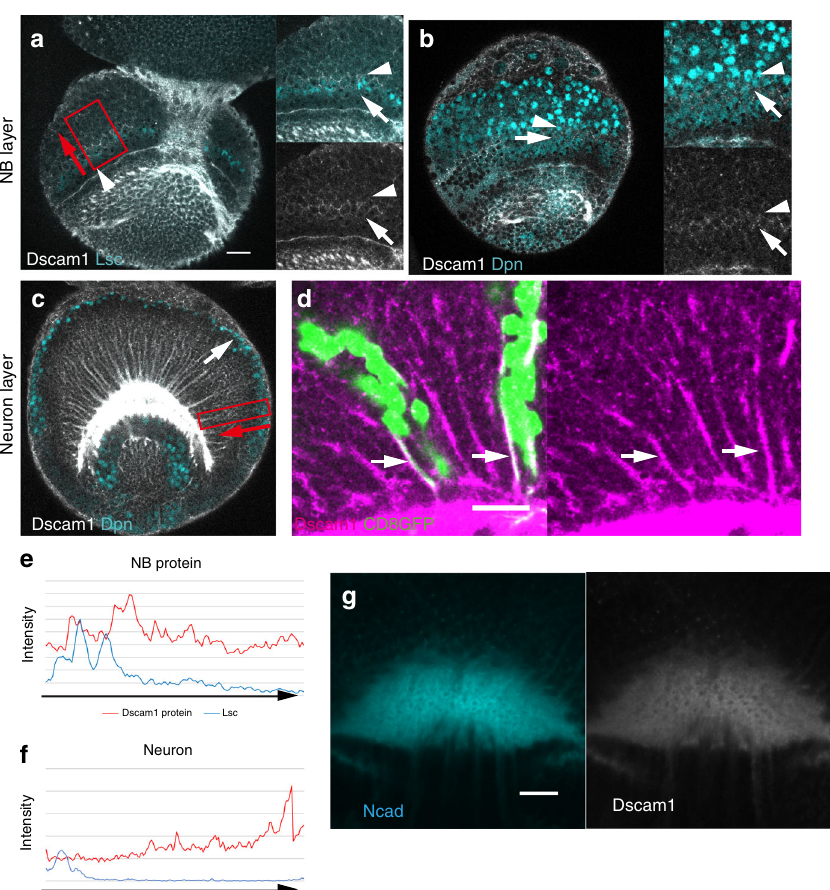
Fig. 3 Expression pattern of Dscam1 protein. a , b Expression pattern of Dscam1 protein (white) in NEs and NBs in a lateral view showing the NB layer (see Fig. 1b). ( a ) Lsc (blue). ( b ) Dpn (blue). c , d Expression pattern of Dscam1 protein (white or magenta) in neurons in a lateral view showing the neuron layer. c Dpn (blue). d Arrows indicate Dscam1 signals along the axons of GFP expressing neurons ( Ay-Gal4 UAS-GFP ; green). e , f Quanti fi cation of Dscam1 signal intensity in the boxes in ( a ) and ( c ), respectively. g Dscam1 (white) and Ncad (blue) visualize the columnar structures in the medulla layer in an anterior view (dotted line in Fig. 1a). Scale bars indicate 20 μ m. Source data are provided as a Source Data fi le ( e , f